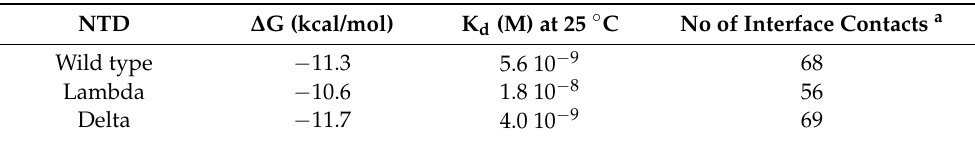
Table 2. PRODIGY prediction of the interaction energies in the complexes between wild-type reference and Lambda Spike NTD with 4A8 Ab.